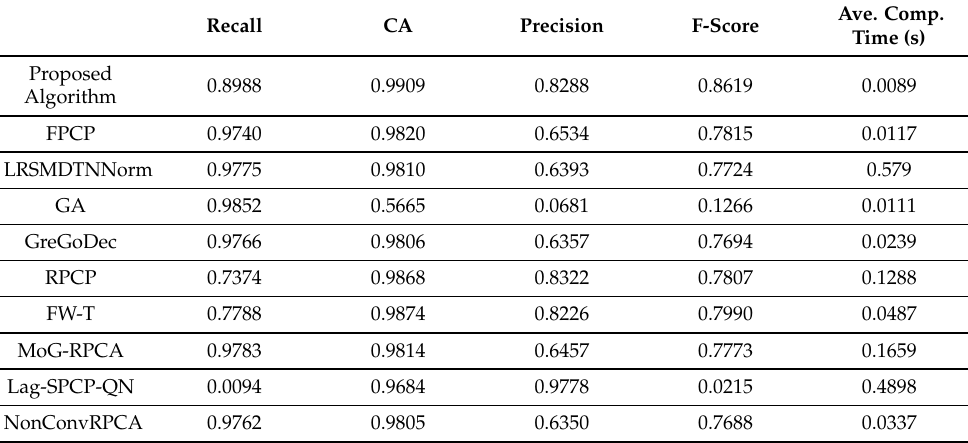
Table 2. Proposed technique foreground segmentation evaluation against different recent algorithms for Video